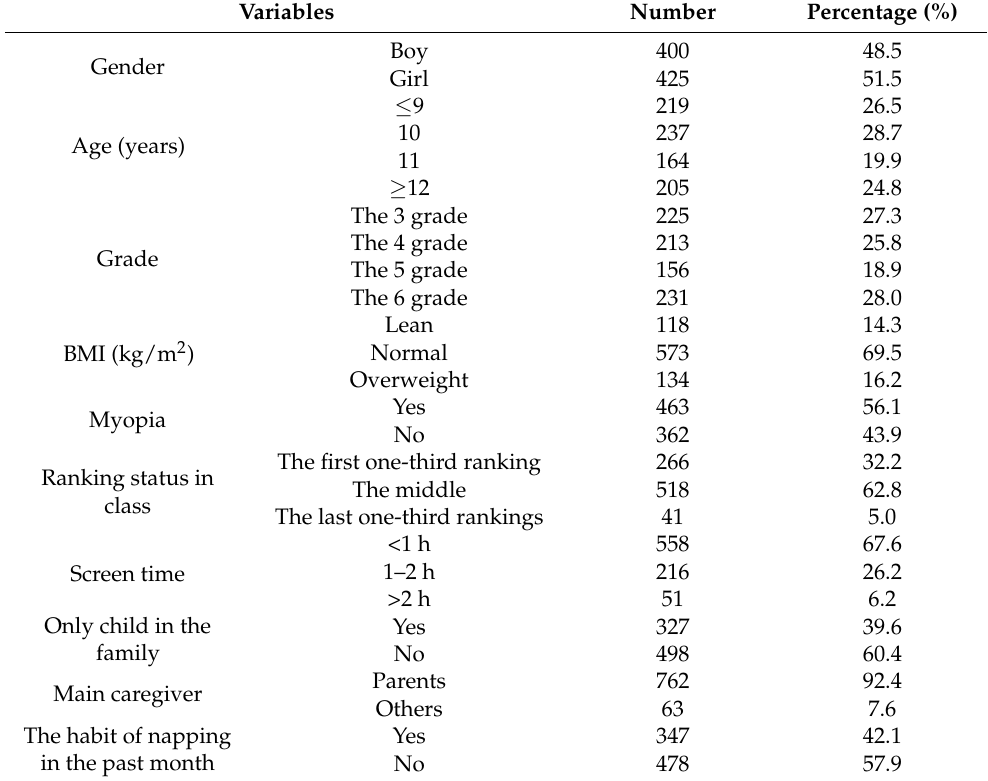
Table 1. Socio-demographic information of participants ( n =